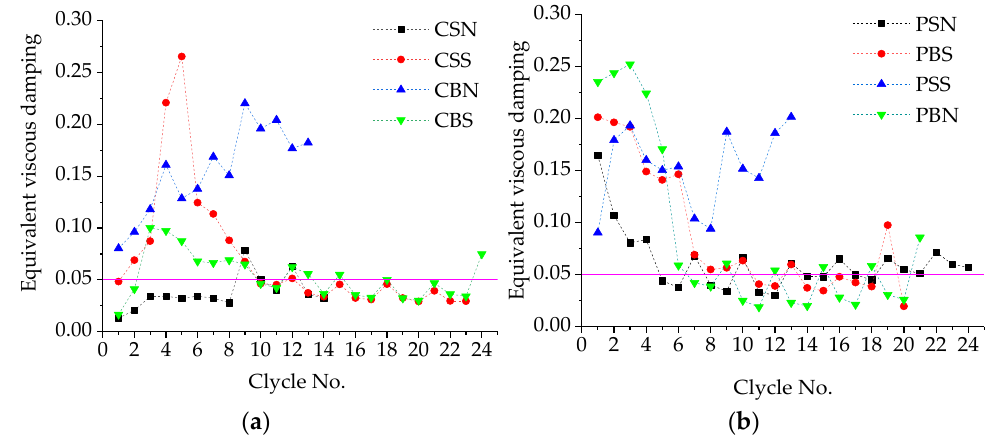
Figure 9. Equivalent viscous damping of the test specimens: ( a ) Perpendicular joints; ( b ) Parallel joints.